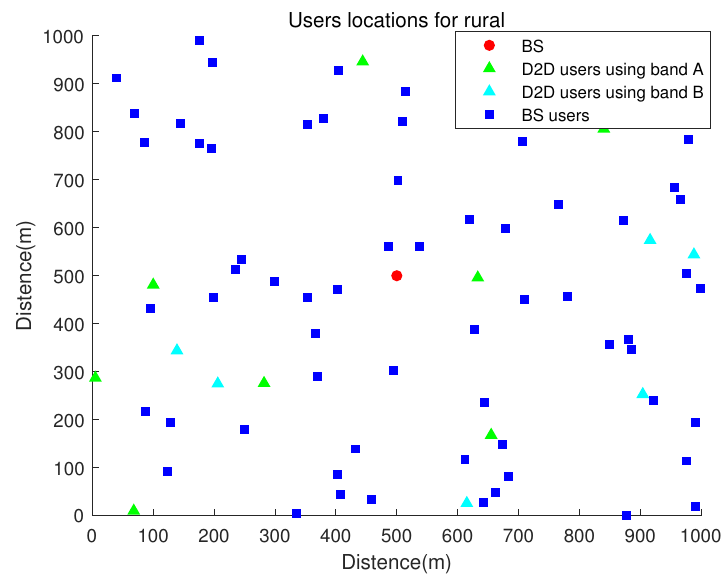
Figure 13. Location map after GADIA for rural environment.